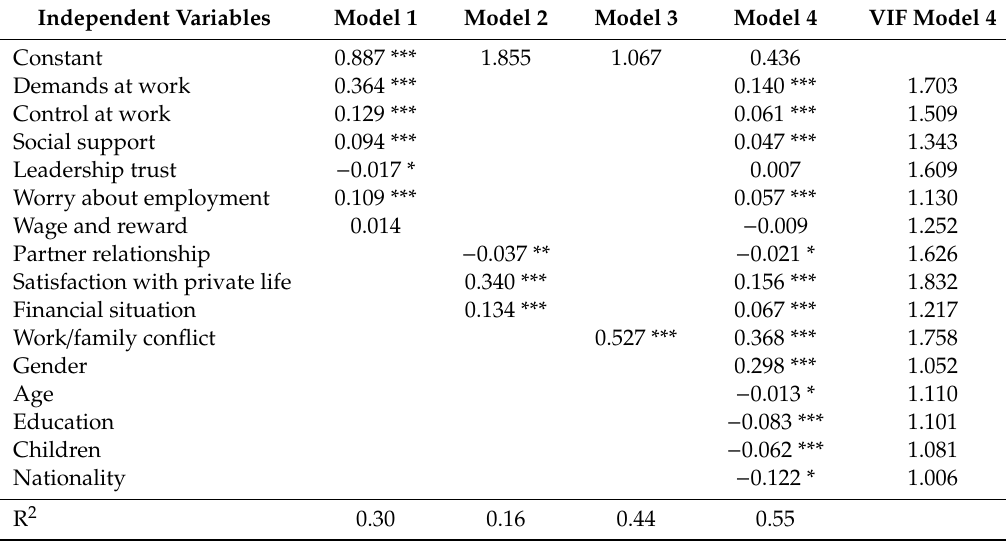
Table 4. Ordinary least squares (OLS) regression. Psychosocial working conditions,